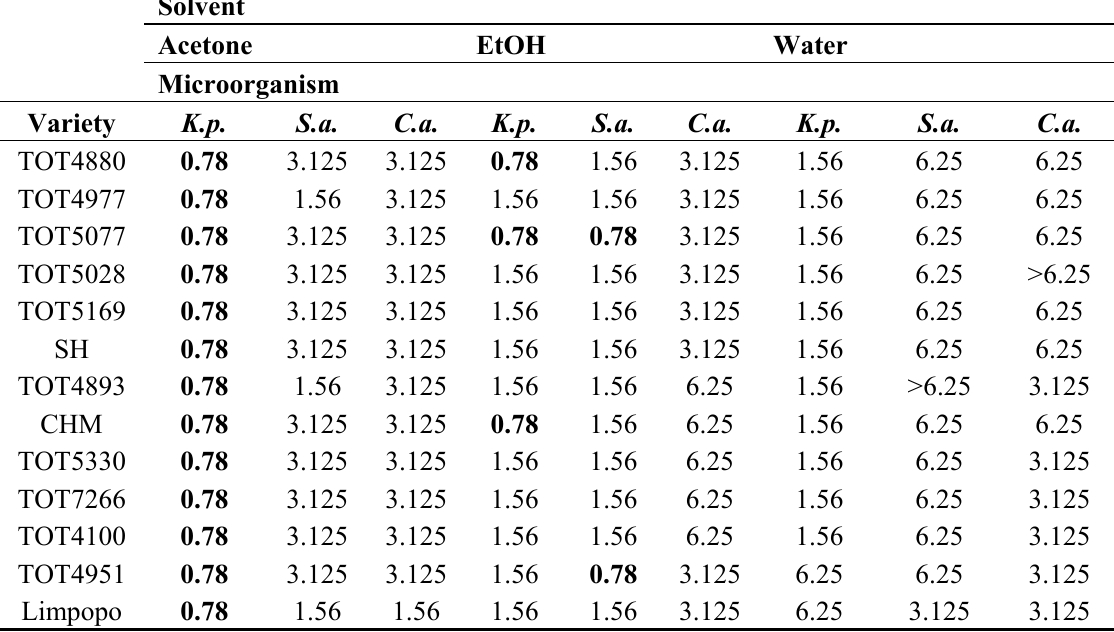
Table 2. Antibacterial and antifungal activities (MIC) of thirteen Moringa oleifera cultivars introduced from different world geographical locations as determined by the microdilution